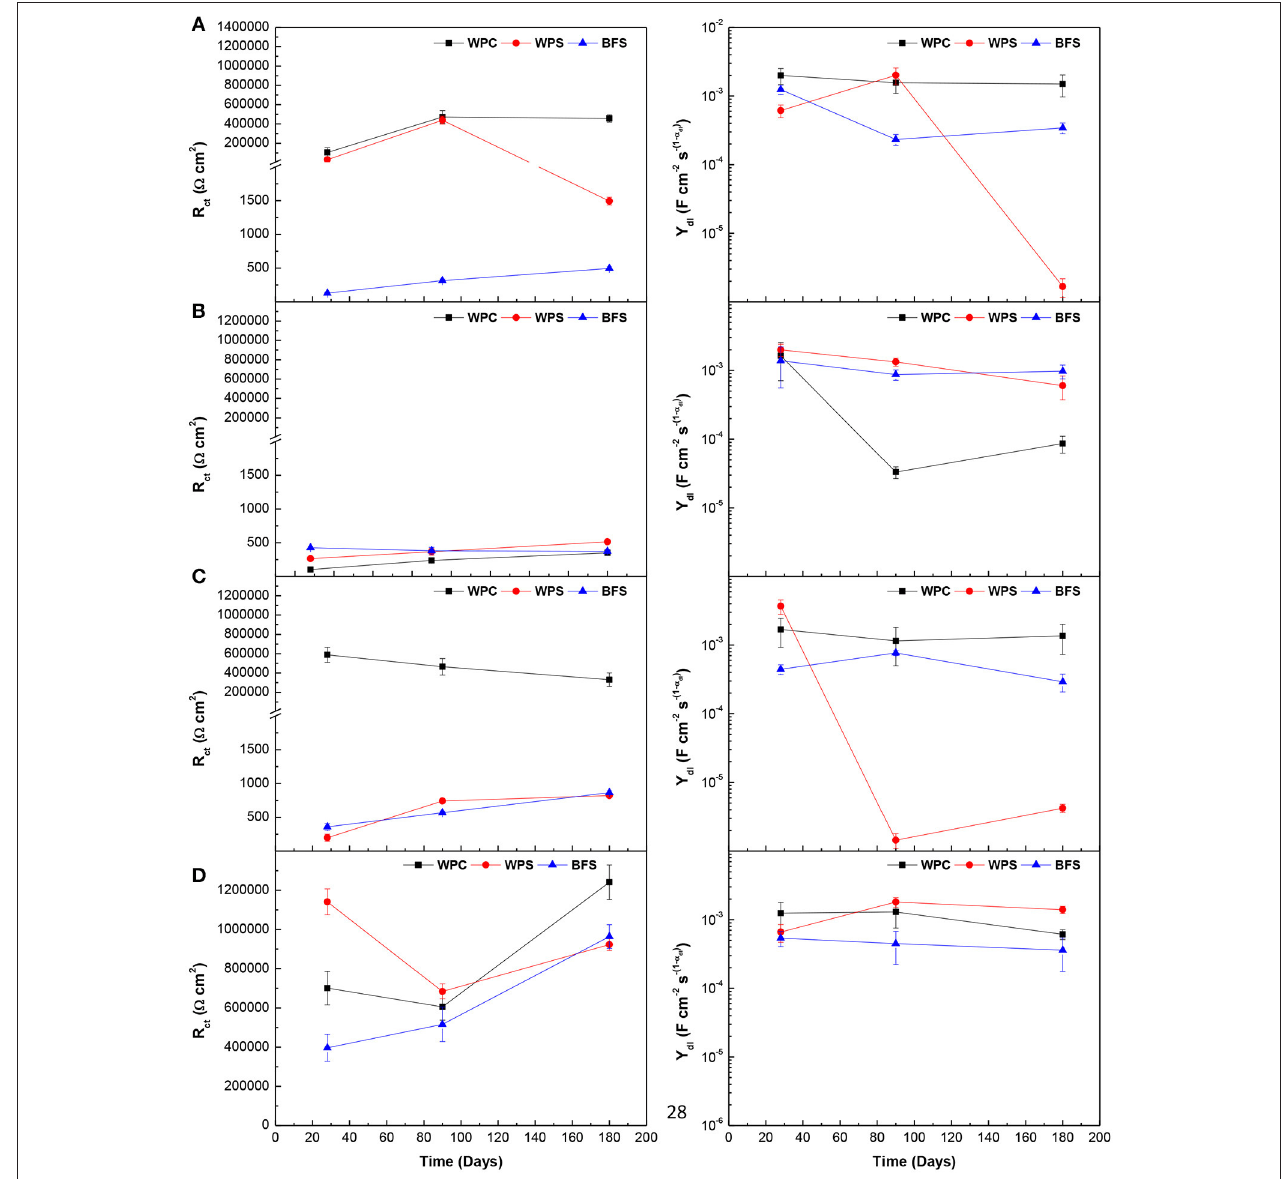
FIGURE 12 | Comparison of charge transfer resistance R ct , and double layer capacitance Y dl , for three types of specimens under different environments: (A) alkaline solution, (B) alkaline chloride-rich solution, (C) water, and (D) standard laboratory